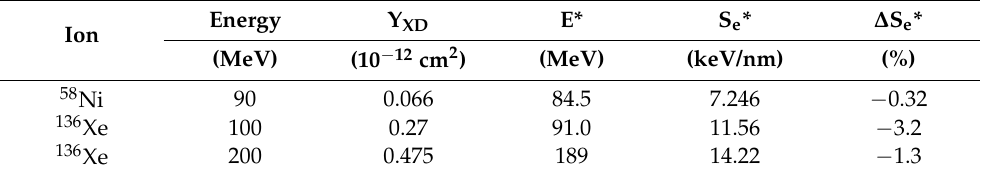
Table 1. XRD data of SiO 2 films. Ion, incident energy (E in MeV), XRD intensity degradation (Y XD ), appropriate E* (MeV) considering the energy loss in the film and electronic stopping power in keV/nm (S e *) appropriate for Y XD (see text). S e from SRIM2013. The deviation ∆ S e * = (S e */S e (E) − 1) × 100 is also